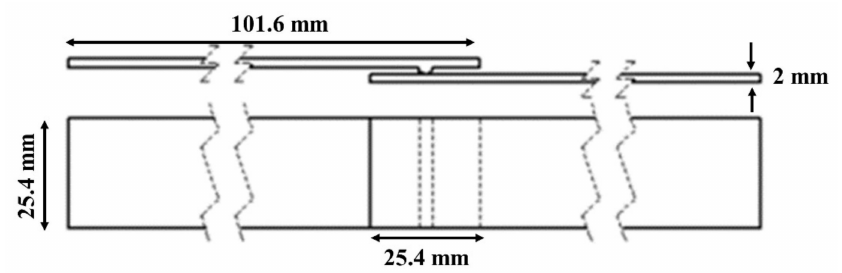
Figure 5. Schematic of Semi-circular ED Elium ® composite_ Flat Elium ® Composite (SC-ELC_FL-ELC) welding configuration.